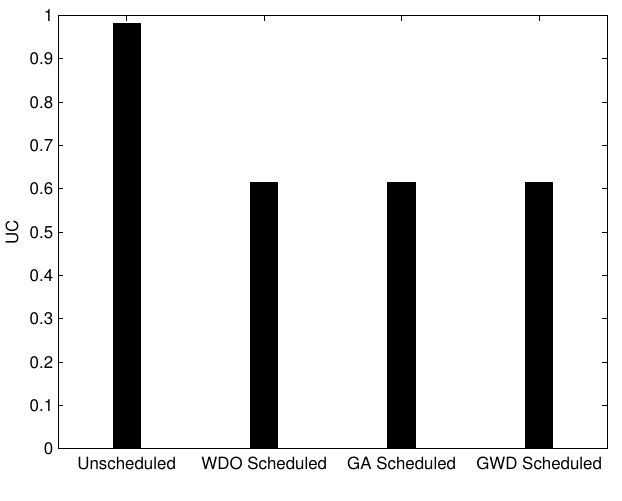
Figure 8. Scheduled and unscheduled